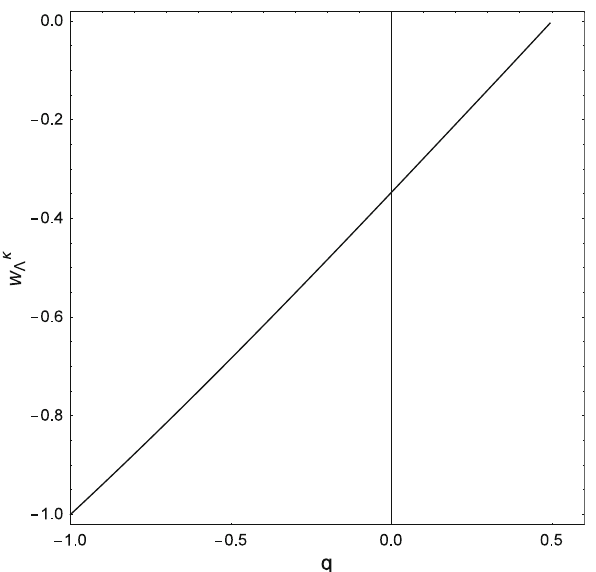
Fig. 2 The behavior of w κ (cid:7) against deceleration parameter for C 2 =